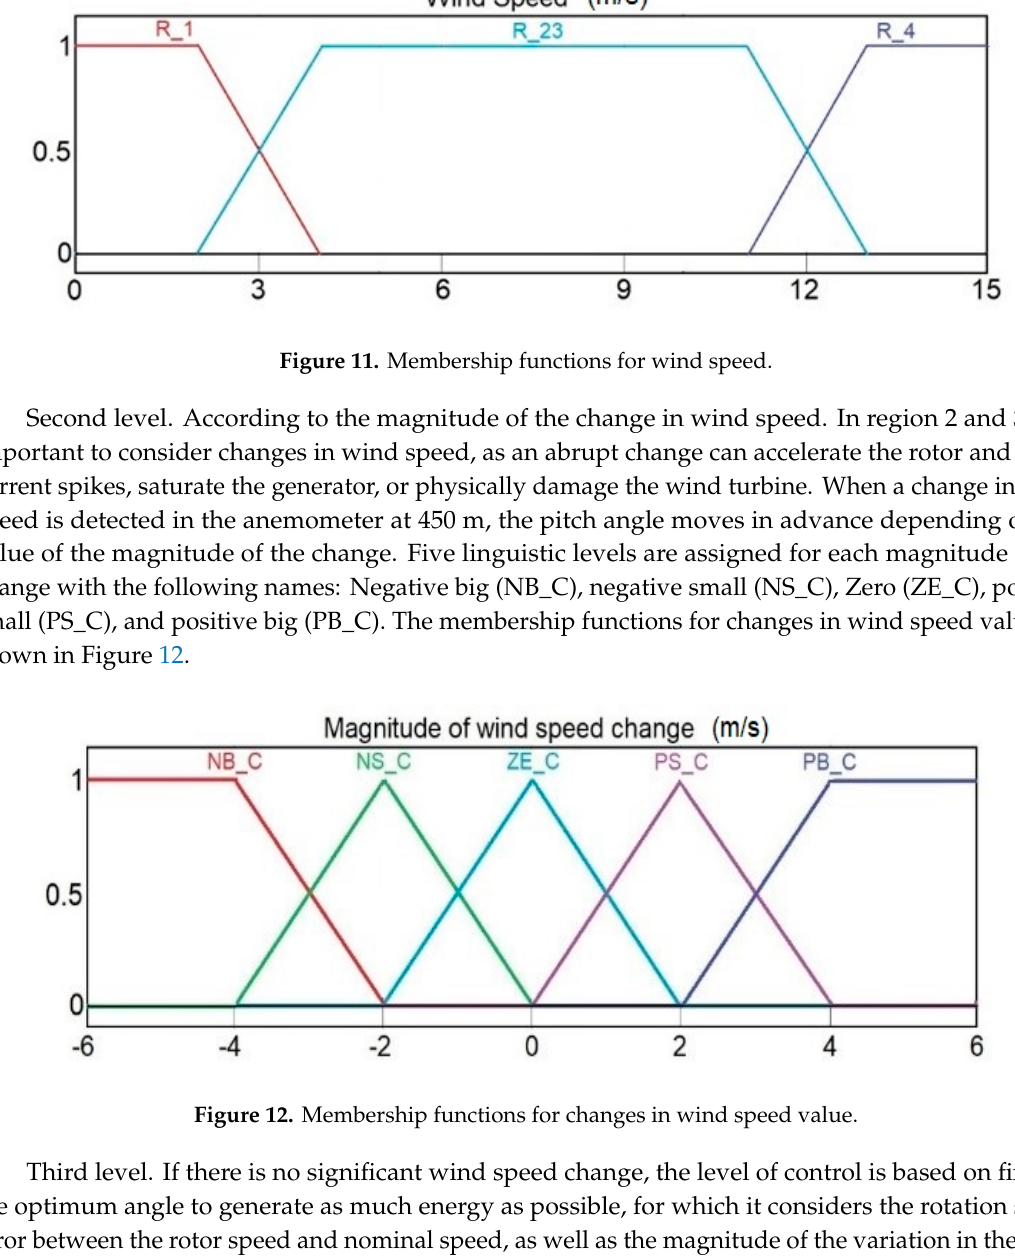
Figure 10. Proposed hierarchical fuzzy logic controller (HFLC) scheme for the pitch angle.